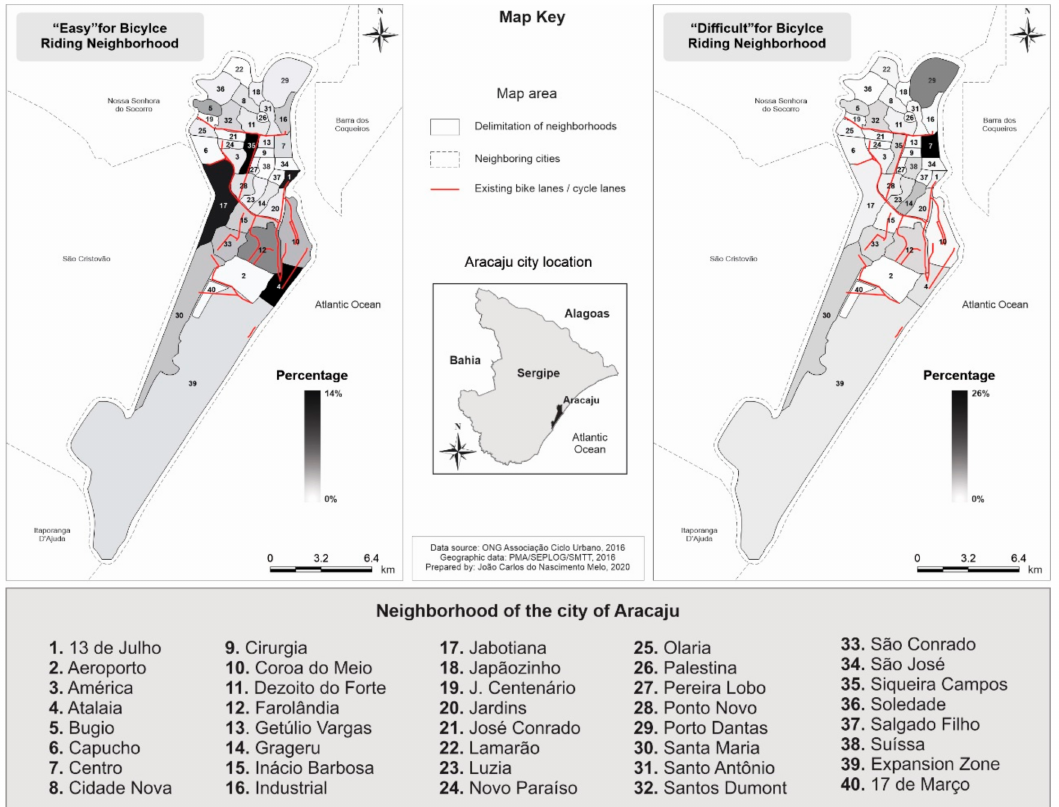
Figure 1. Perception of the di ffi culty of cycling in Aracaju /